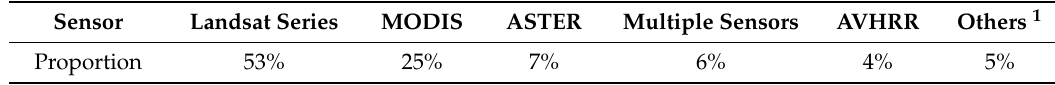
Table 1. Proportion of reviewed SUHI studies using various satellite images. Sensor Landsat Series MODIS ASTER Multiple